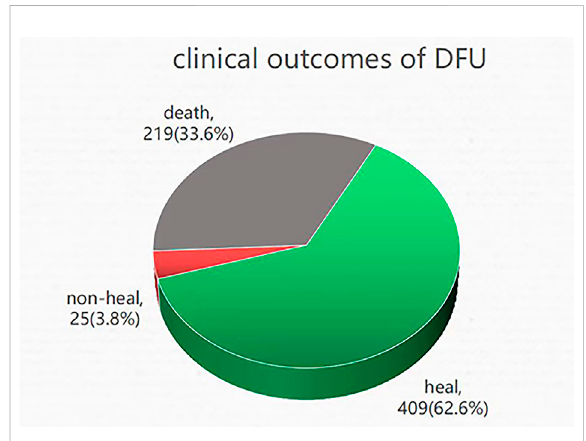
FIGURE 1 Clinical outcomesof DFU: death, non-healing, and healing.A total of 653 patients underwent successful follow-up, of which 33.6% of DFU patients lost their lives, 62.6% of DFU patients were healing, and 3.8% of DFU patients were